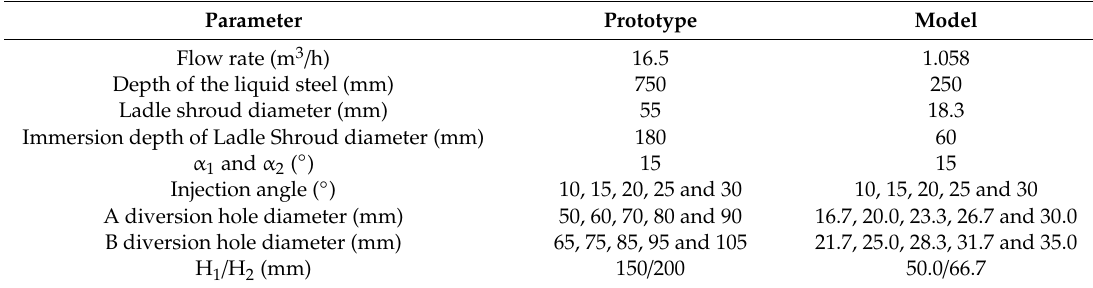
Figure 1. ( a ) Parameters for the tundish prototype. ( b ) Sketch view of the diversion wall. ( c ) Sketch view of the turbulence inhibitor (units in millimeters). Table 1. Geometrical parameters for the prototype and model.